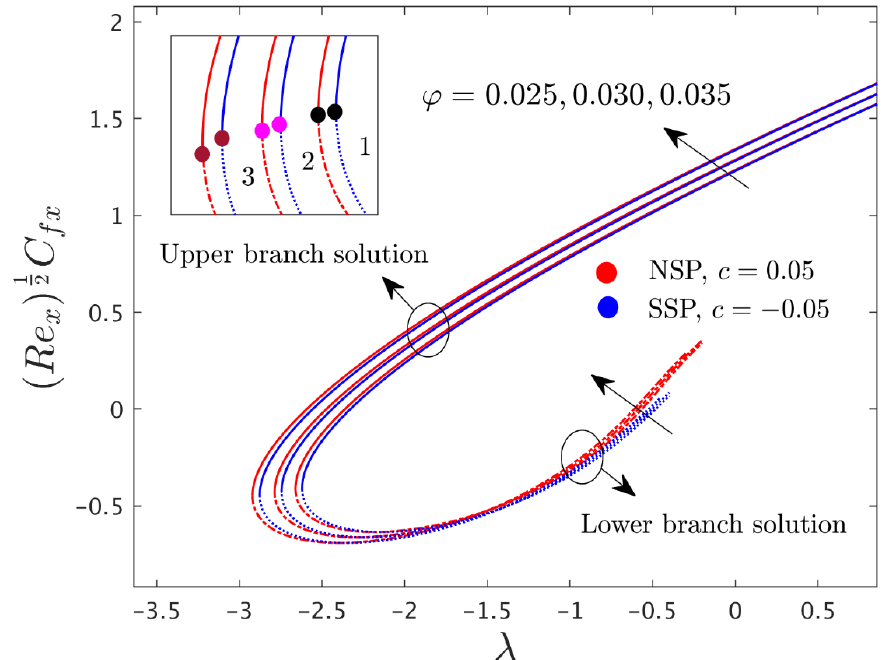
Figure 6. Skin friction coefficient Re x 1/2 C fx in the x -axis direction for varying ϕ .